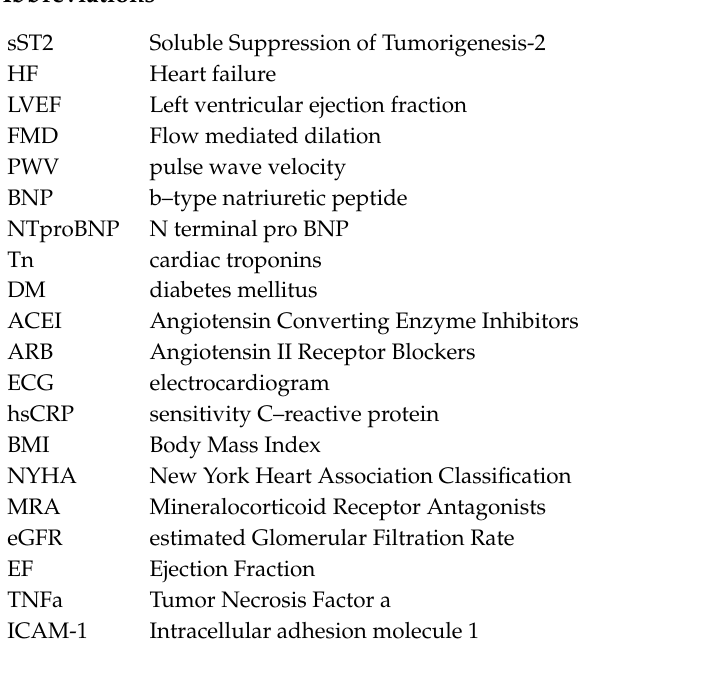
s1, Figure S1: Multi-panel figure (A–K) showing how sST2 levels are associated with continuous and categorical variables in the heart failure